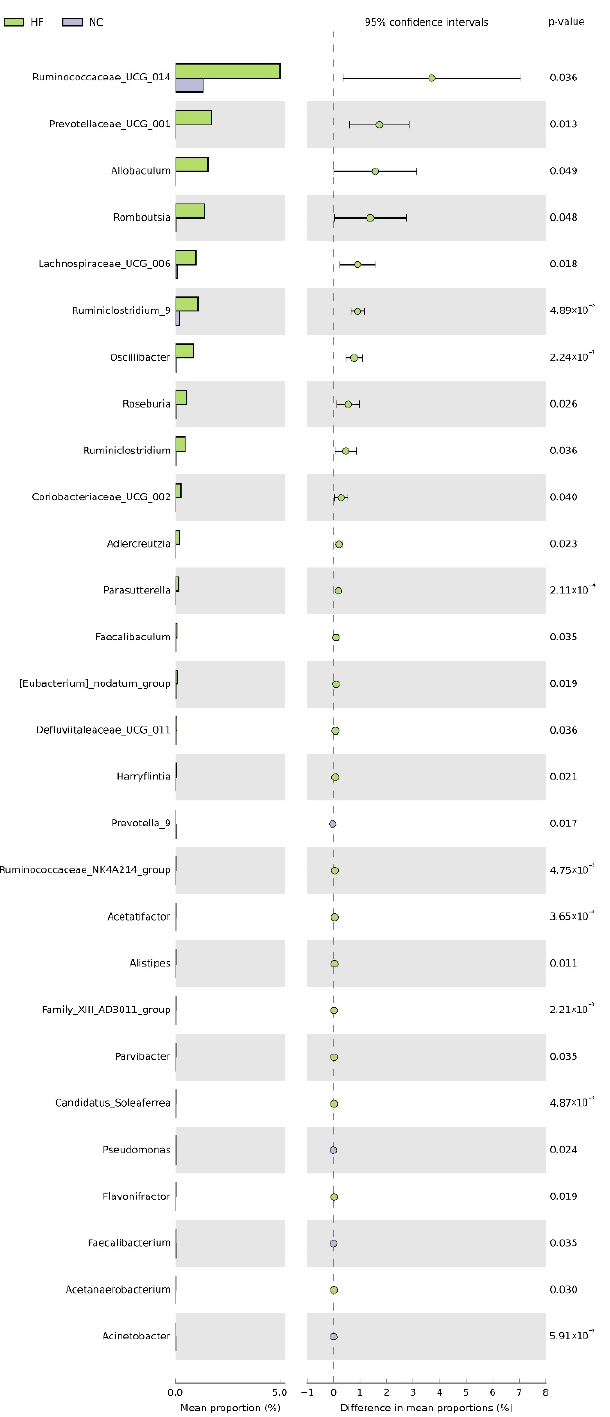
Figure 5. STAMP analysis of bacterial taxon shown at the genus level between normal control (NC) and high-fat control (HF) groups. The value of p < 0.05 was considered significant ( n = 5 per group).